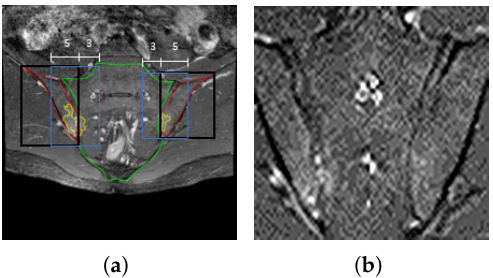
Figure 3. Data normalization. ( a ) Bounding boxes for the ROI (blue boxes) containing the left and right iliac bones (black boxes)); ( b ) ROI patch combining bounding boxes obtained from left and right iliac bone regions (blue boxes in ( a )) with random